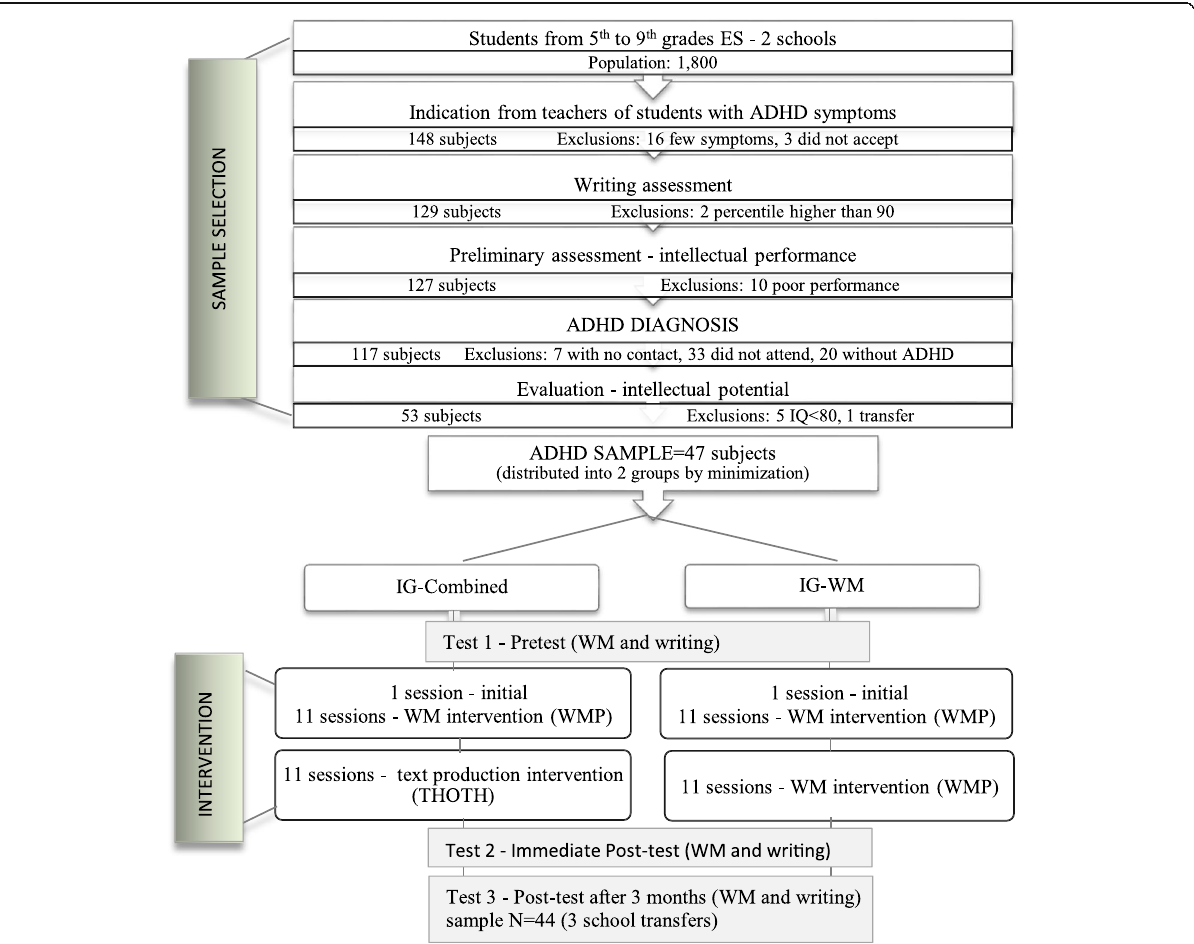
Fig. 1 Flowchart of research stages. IG-Combined: combined intervention group, IG-WM: WM intervention group, WMP: Working Memory Program, WM: Working Memory, THOTH: Trabalhando com Habilidades de Organização de Textos Harmônicos [Working with Harmonic Text Organization